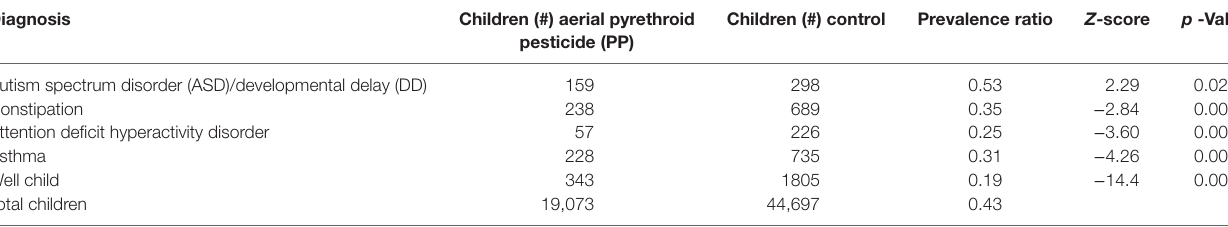
TaBle 2 | health center utilization rates for common pediatric conditions.